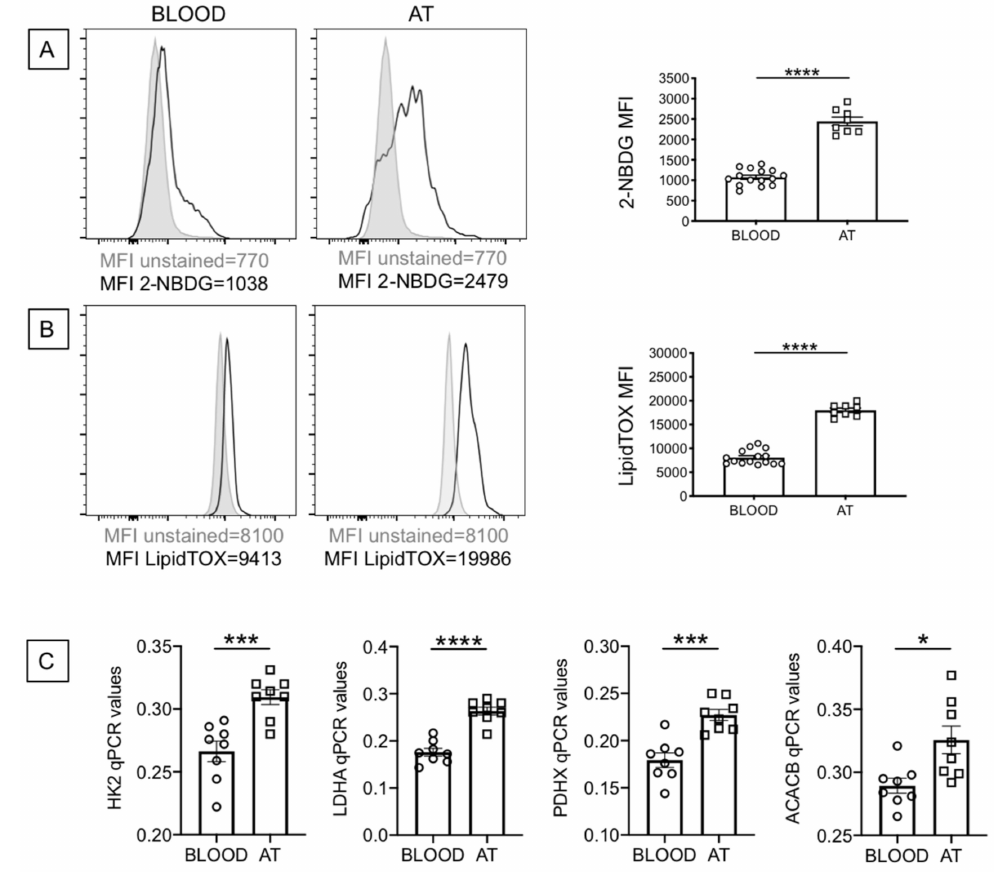
Figure 3. B cells from the AT of individuals with obesity are highly metabolic as compared to those from the peripheral blood. ( A ) Glucose uptake was measured by flow cytometry and the glucose fluorescent analog 2-NBDG.Results show the MFI (mean fluorescence intensity) profile of one representative blood donor and one representative AT donor ( left 2 panels ) and data from all donors ( right ). ( B ) Lipid uptake was measured by flow cytometry and the Deep Red Neutral Lipid Stain LipidTOX. Results show the MFI profile of one representative blood donor and one representative AT donor ( left 2 panels ) and data from all donors ( right ). ( C ) The mRNA was extracted and qPCR performed to evaluate expression of HK2, LDHA, PDHX and ACACB. qPCR values are measures of RNA expression of target genes, relative to the housekeeping gene GAPDH, calculated as 2 − ∆ Cts . Mean comparisons between groups were performed by Student’s t test (two-tailed). * p < 0.05, *** p < 0.001, **** p <